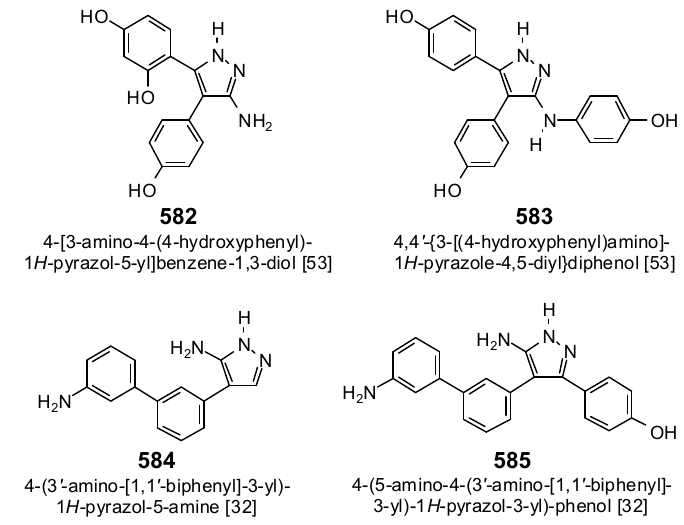
Figure 29. Structures of the synthetic cytochrome P450 CYP121 inhibitors.